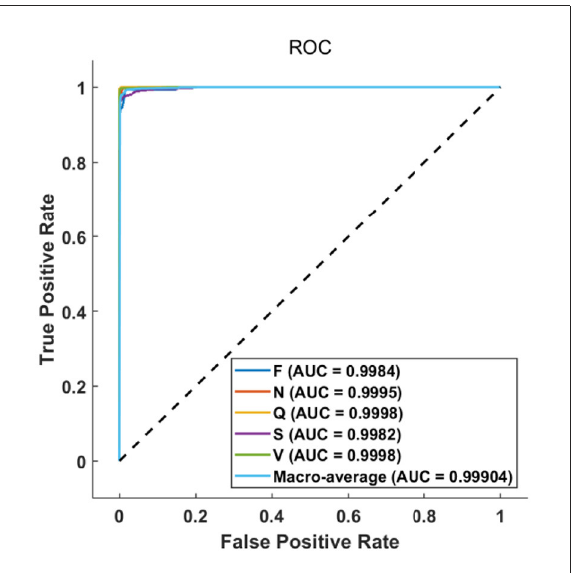
FIGURE7 ROC of classification result and their AUCs.